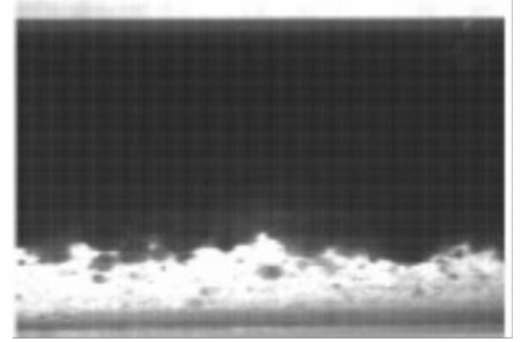
Figure 16. Flow pattern at U oil = 0.325 m / s, U water = 0.325 m / s—experiment [11].